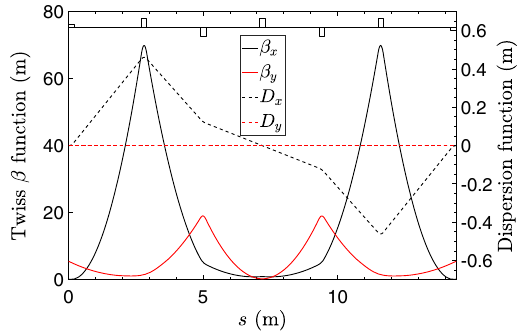
FIG. 2. Twiss β and dispersion functions along the transfer